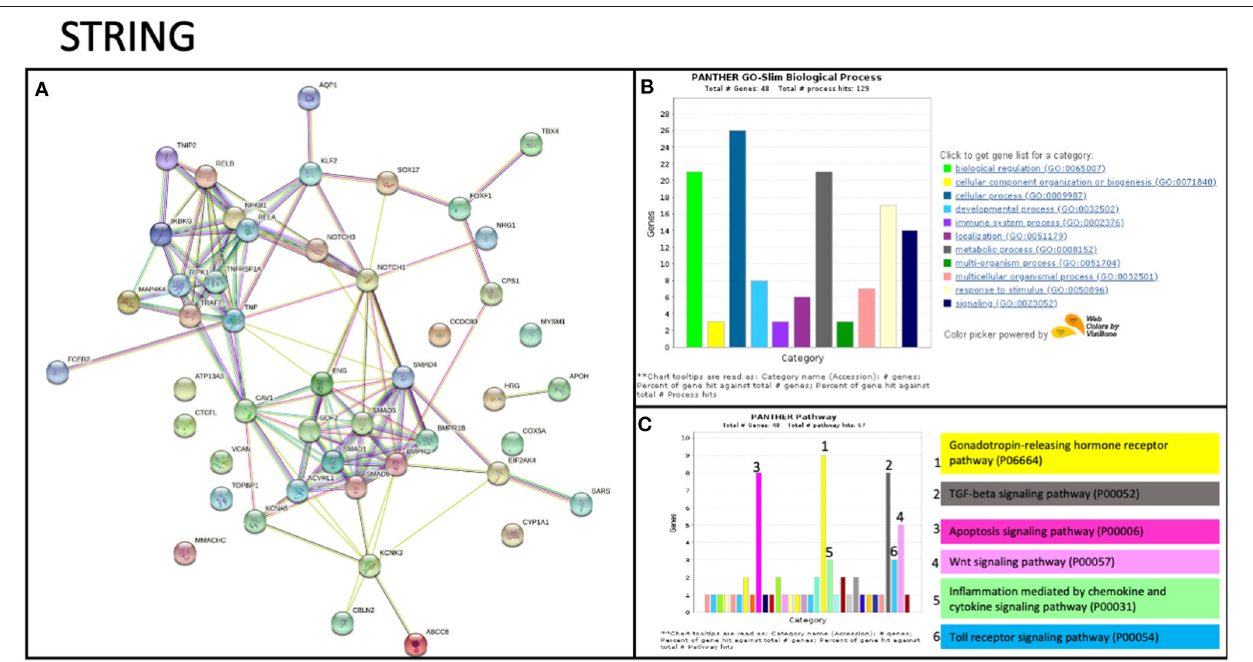
FIGURE 2 | STRING analysis of TRAF2 and TNIP2 related to previously associated genes to PAH. (A) Protein network showing the possible interactions between all genes associated with PAH. This graph includes genes previously associated with PAH and candidate genes described in case reports/series. The strength of evidence for the relation between TRAF2 and CAV1 comes from published experimental/biochemical data and association in curated databases (see Methods). (B,C) Gene enrichment analysis, including biological processes (B) and interaction pathways (C) in which the STRING analysis genes are involved. Several genes are involved in the immune system process and participate in inflammation mediated by chemokine and cytokine